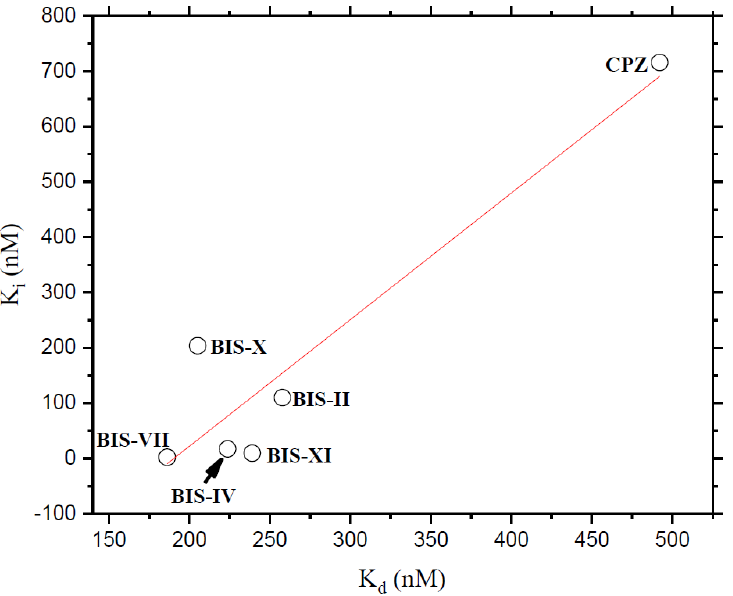
Figure 5. Relationship between experimental K d and theoretical K i of the BIM ligands.